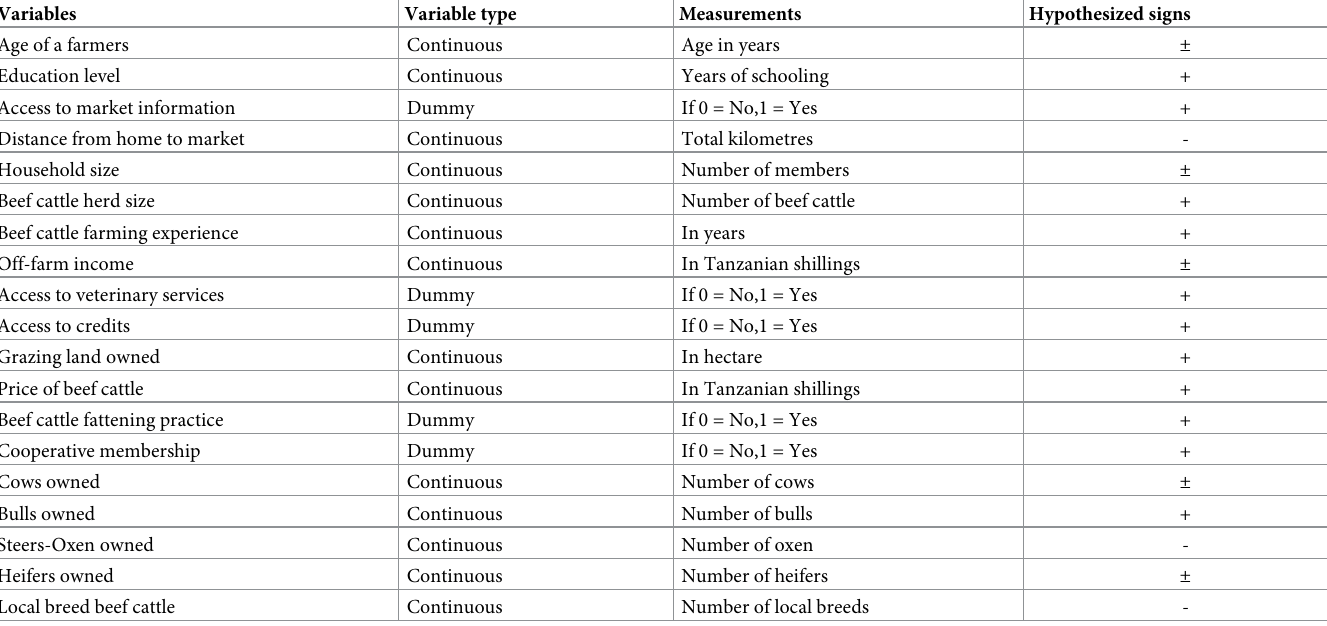
Table 2. Independent variables and their expected effects on the volume of beef cattle sold by beef cattle